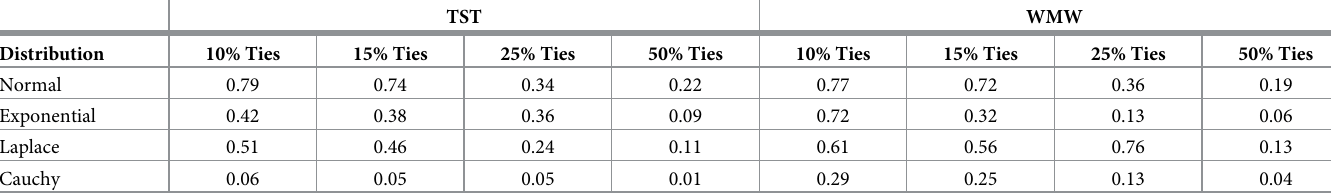
Table 1. Maximum power for jittering method according to percentage of tied observations.